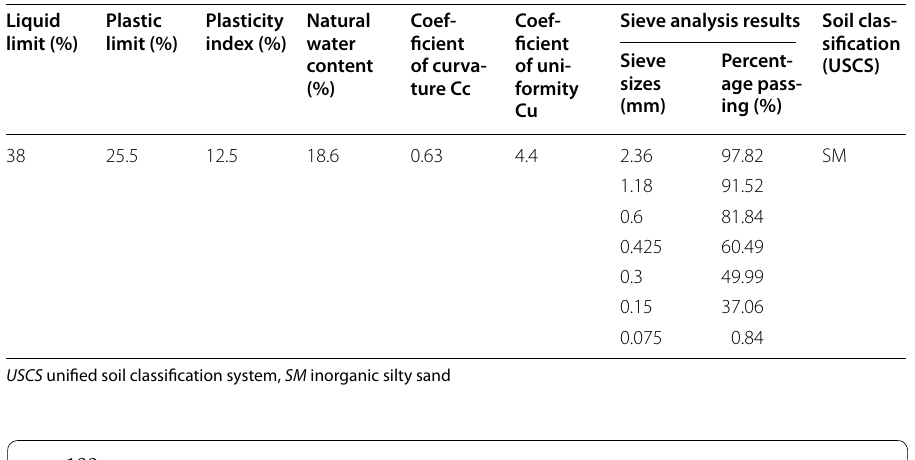
Table 1 Soil index properties and classification